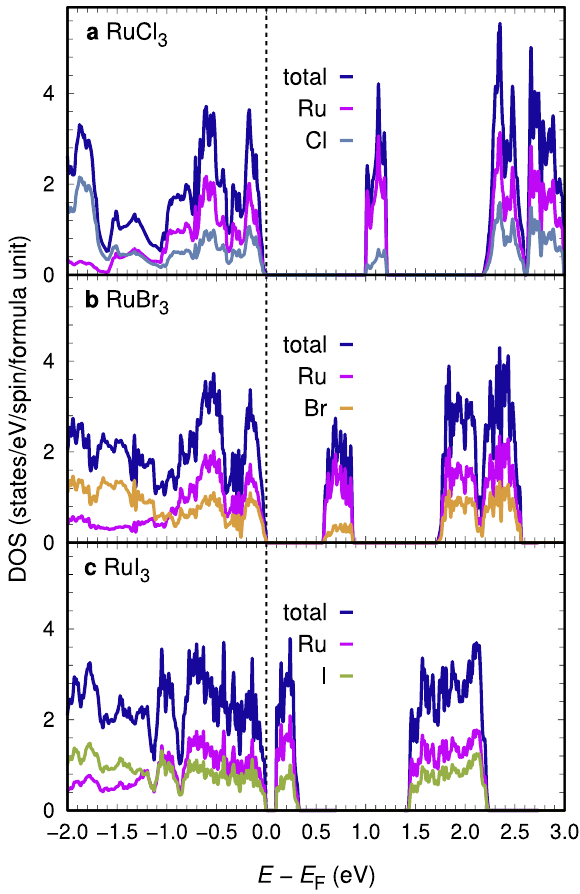
Fig. 3 Density of states for RuX 3 (X = Cl, Br, I). Density of states (DOS) for the experimental structures of RuCl 3 , RuBr 3, and RuI 3 , obtained from GGA + SO + U calculations with Wien2k, considering antiferromagnetic zigzag magnetic con fi gurations. For RuCl 3 we employed U eff = 2.7 eV, for RuBr 3 U eff = 2.1 eV and for RuI 3 U eff = 1.4 eV. Shown is also the contribution of Ru and halogen states to the